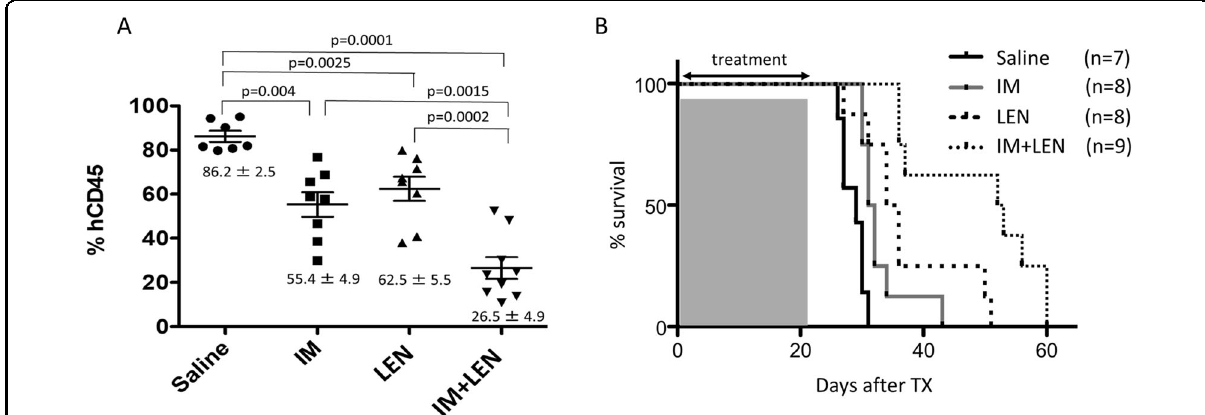
Fig. 7 Engraftment and survival rate of NOG mice xenografted with KOPN57bi cells treated with LEN and/or IM. Approval was obtained from Animal Care Committee of Tokai University before performing experiments (approval number 182009). The NOD/Shi-scid, IL-2R γ null (NOG) mice were transplanted with KOPN57bi cells (2 × 10 6 ) intravenously from retro-orbital plexus after 2 Gy radiation. Cells were intravenously infused into 7 – 9 weeks of 2 Gy irradiated NOG mice (In-Vivo Science, Tokyo, Japan). Mice were divided into 4 groups receiving saline ( n = 7), IM (Novartis Pharmaceuticals, East Hanover, NJ), 150 mg/kg/day, n = 8), or LEN (30 mg/kg/day, n = 8) alone, or LEM plus IM ( n = 9) for 3 weeks, and survivals were observed over 60 days. A Engraftment. Two weeks after the infusion of leukemia cells, BM cells were aspirated from a long-leg bone in a living state under anesthesia condition and stained with APC-conjugated anti-human CD45 monoclonal Ab (Beckman Coulter, Brea, CA). The human CD45-positive rate in BM was evaluated as engraftment rate in each group by fl ow cytometric analysis. Engraftment rate in the LEN plus IM group was decreased to 26.5 ± 4.9% which was signi fi cantly lower than in the group of IM (55.4 ± 4.9%) or LEN alone (62.5 ± 5.5%). P values were calculated by unpaired t -test. B Survival. Survival rates were evaluated in each group for over 60 days. The median survival in the LEN plus IM group was elongated to 52.5 days, which was signi fi cantly ( p < 0.002 by rog-rank test) longer than that in the group of IM (31.5 days) or LEN alone (35.0